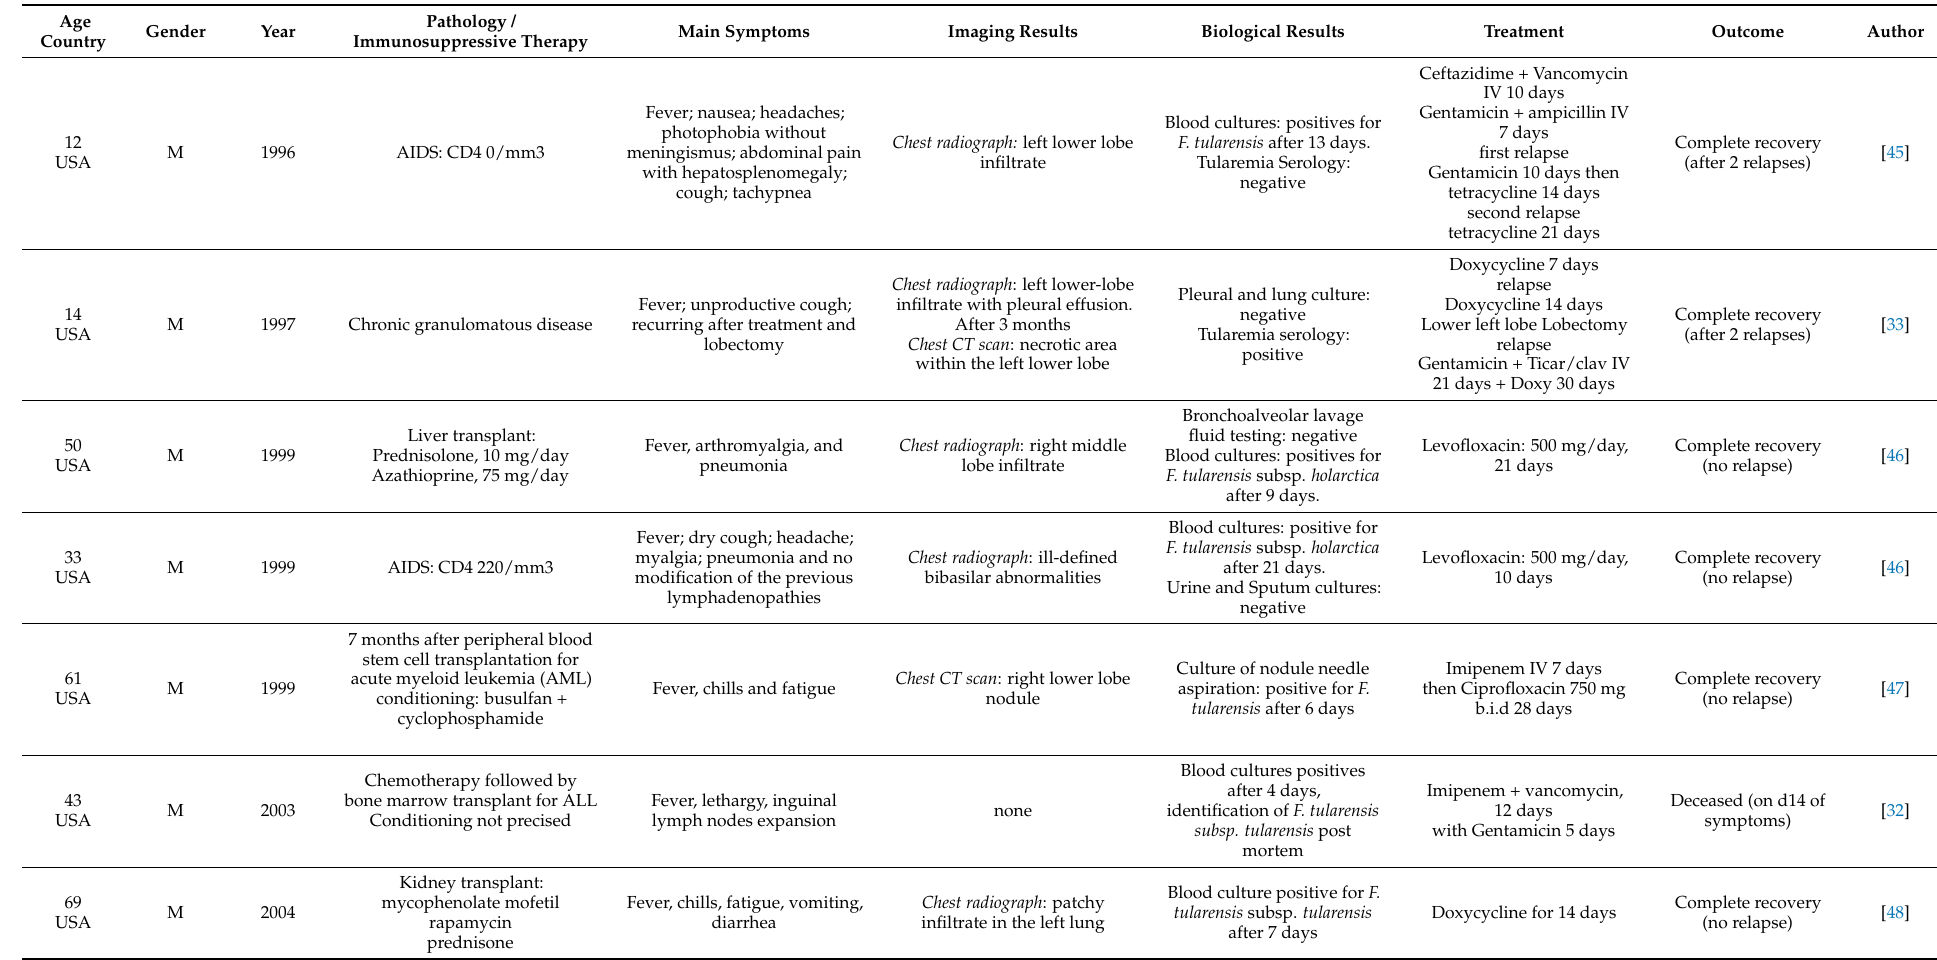
Table 1. Cases of tularemia in immunocompromised patients from